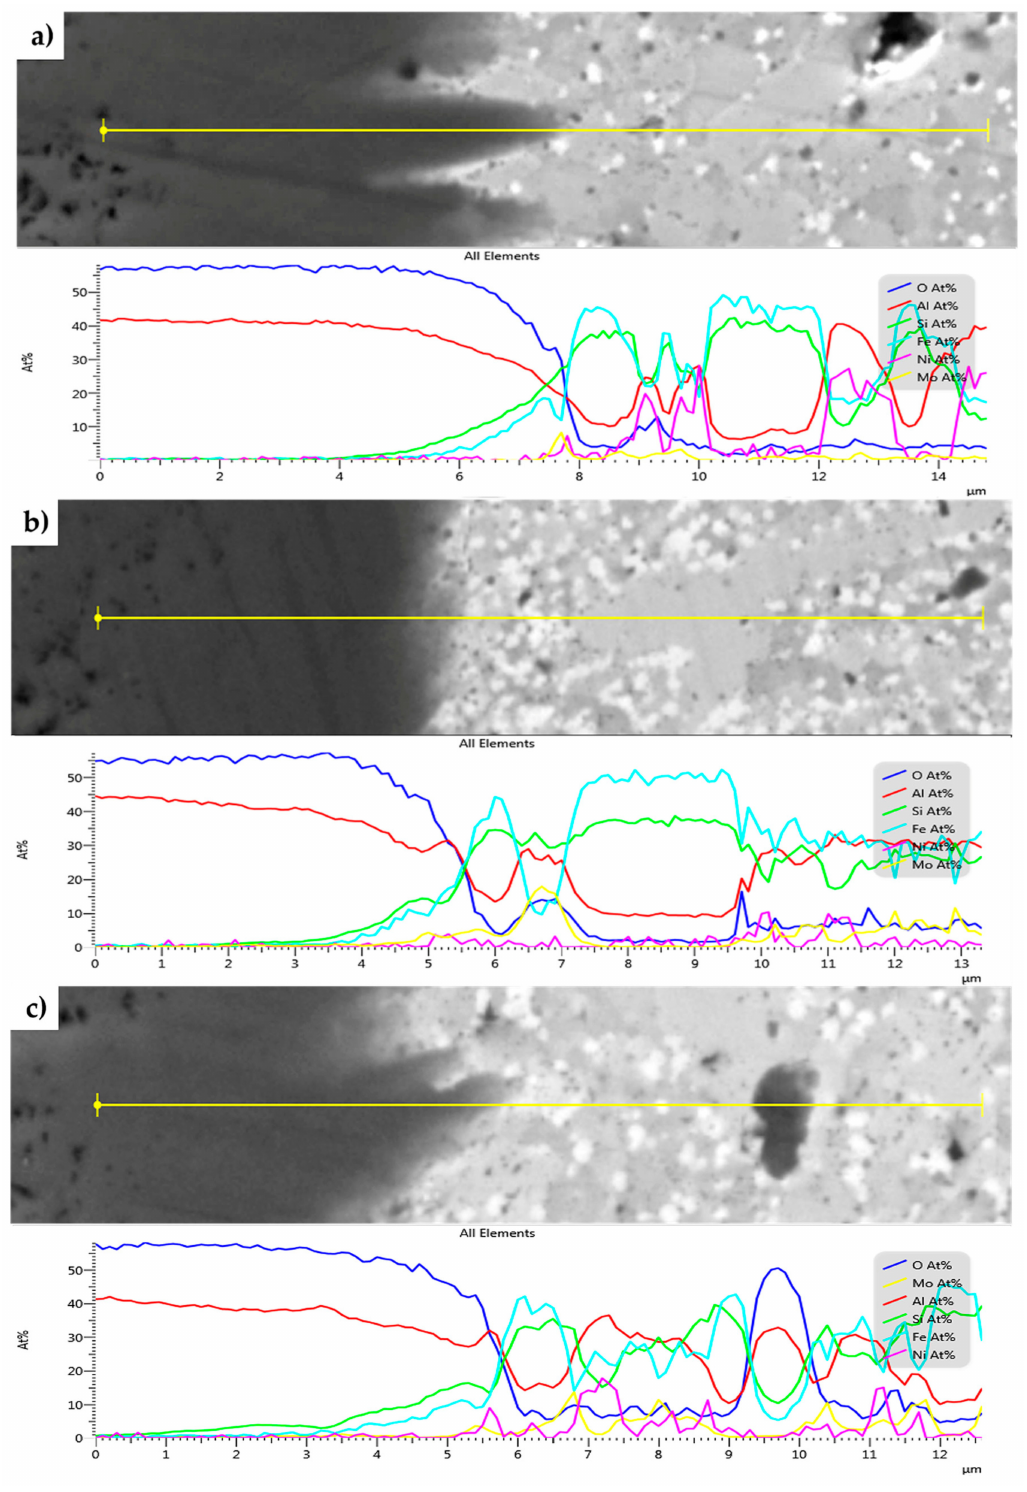
Figure 10. SEM + EDS linescans across the oxide layers formed on the MA + SPS: ( a ) FeAl20Si20Mo5Ni15; ( b ) FeAl20Si20Mo10Ni10; and ( c ) FeAl20Si20Mo15Ni5 alloys after 100 h of cyclic oxidation at 800 ◦